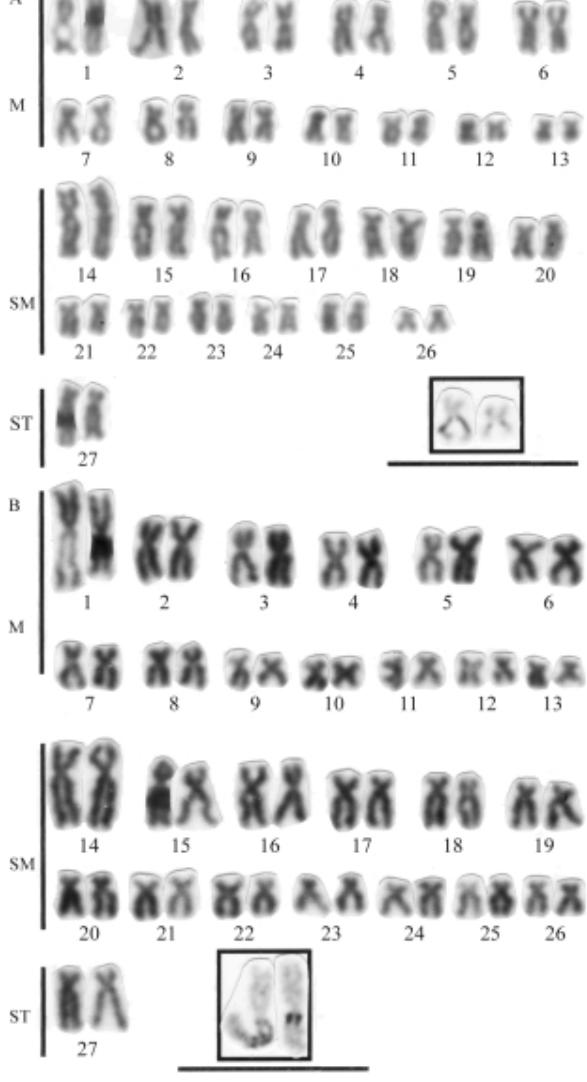
Figure 2 - Giemsa stained karyotypes of Hisonotus species A and D from São Paulo State. A = species A from Salesópolis; B = species D from Pindamonhangaba. Inset, the Ag-NOR-bearing chromosome pairs. Bars = 10 (cid:1)